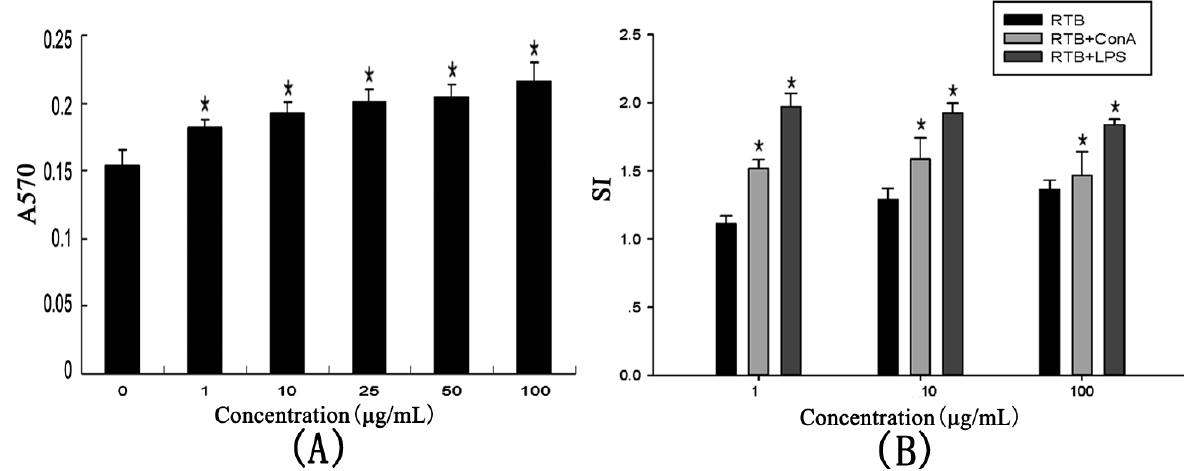
Figure 5. Effects of RTB on proliferation of mouse splenocytes in vitro . ( A ) Splenocytes were measured with treated RTB (from 0 to 100 μ g/mL) for 48 h; ( B ) Splenocytes were measured with RTB (1, 10 and 100 μ g/mL) in the presence of 2.5 μ g/mL ConA or 5 μ g/mL LPS for 48 h. The absorbance at 570 nm was measured. SI (RTB) = mean A570 of RTB/mean A570 of media control, SI (mitogen) = mean A570 of RTB + ConA or LPS/mean A570 of ConA or LPS. Values are the mean ± SD of three replicates. * p < 0.01 compared to the control